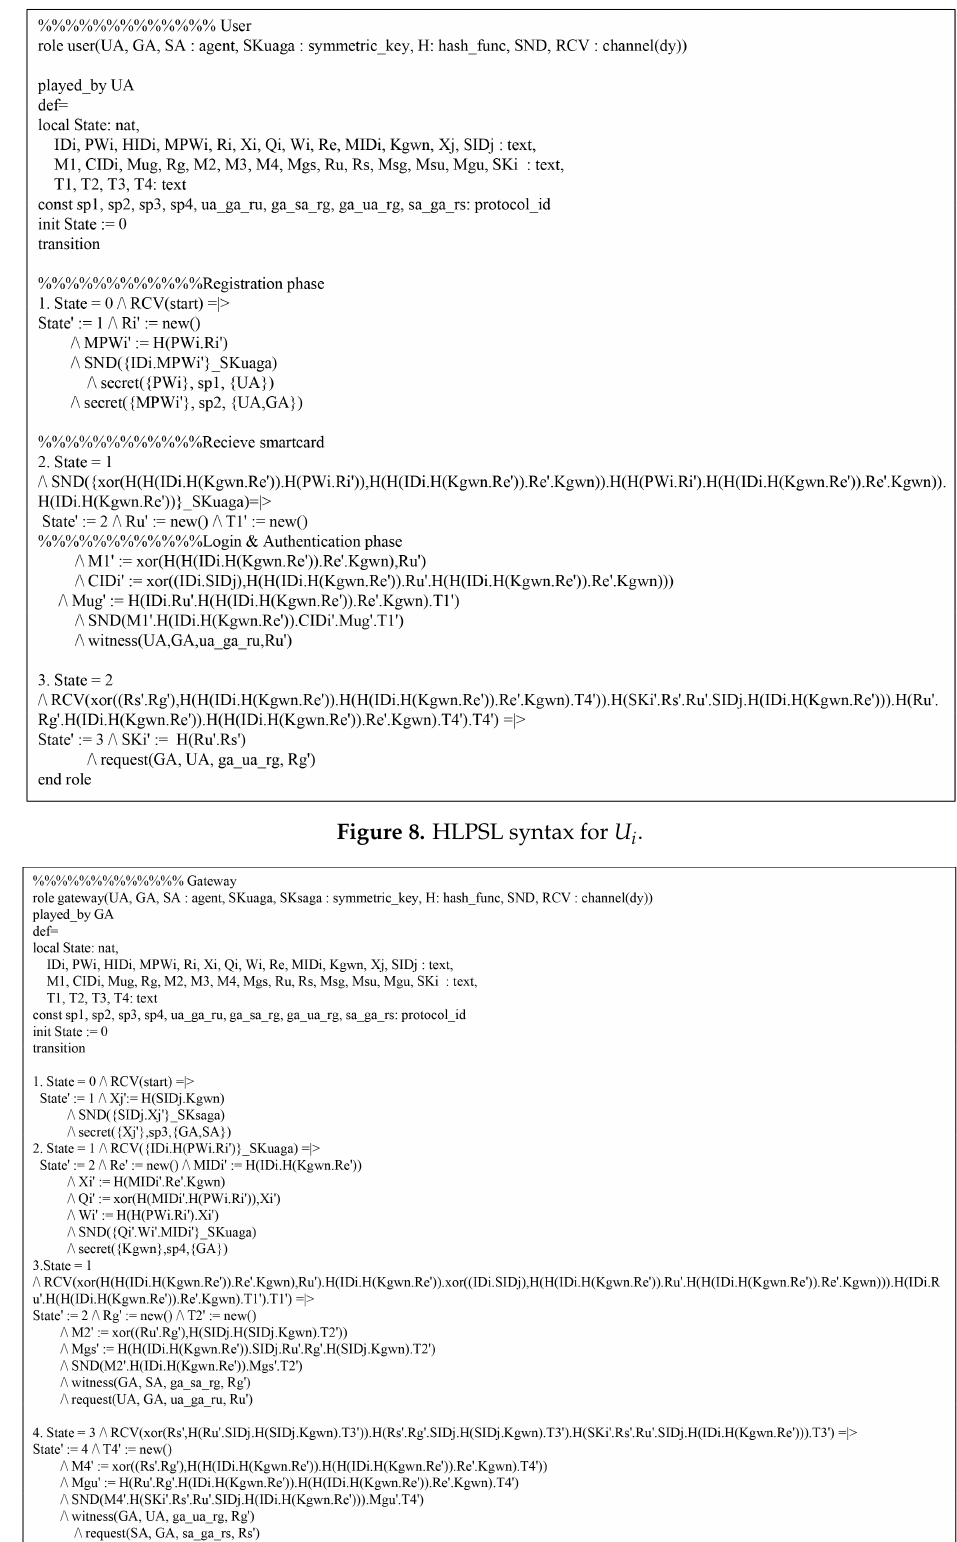
Figure 9. HLPSL syntax for GWN